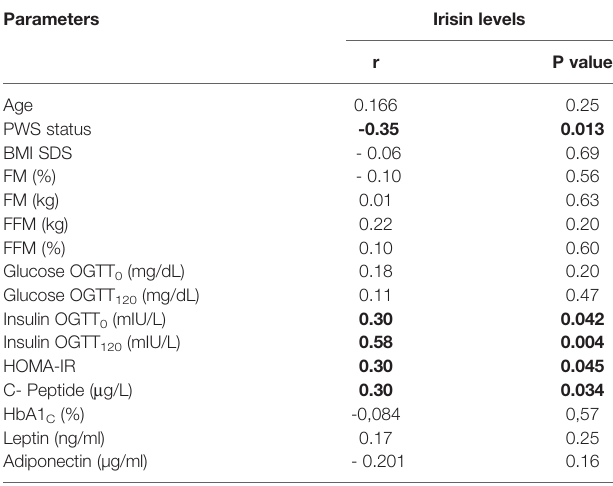
TABLE 4 | Regression coef fi cients derived from the stepwise multivariable regression analysis conducted in the PWS subjects and obese controls as a whole on irisin as the dependent